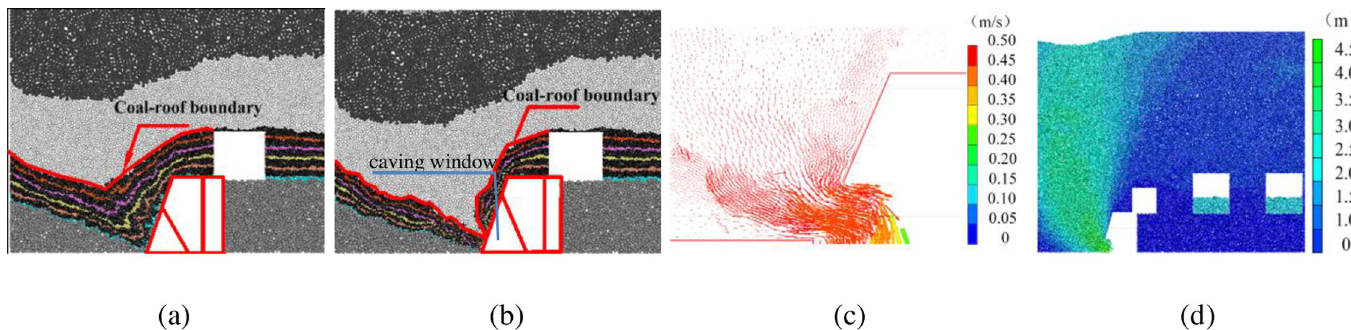
Fig 3. Coal and roof mass caving characteristics after 4.5 m of face advance below solid coal: (a) Coal-roof mass boundary before caving; (b) Coal-roof mass boundary after caving; (c) Particle velocity vectors at caving window; (d) Particle displacement.